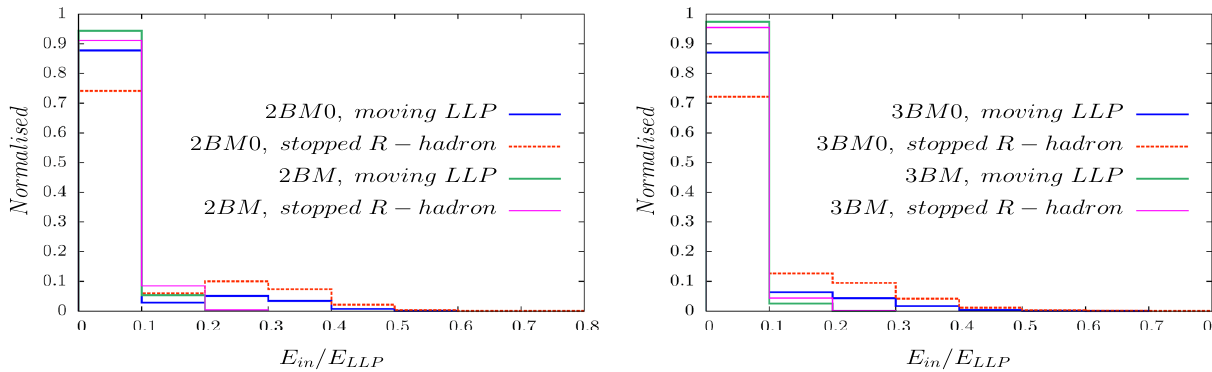
Fig. 14 Normalised distribution of E in / E LLP ; M X = 2 TeV, M DM = 1 . 5 TeV. For the definition of the 2BM/3BM decays, see the text. For the first bin ( E in / E LLP < 0 . 1) E in = 0